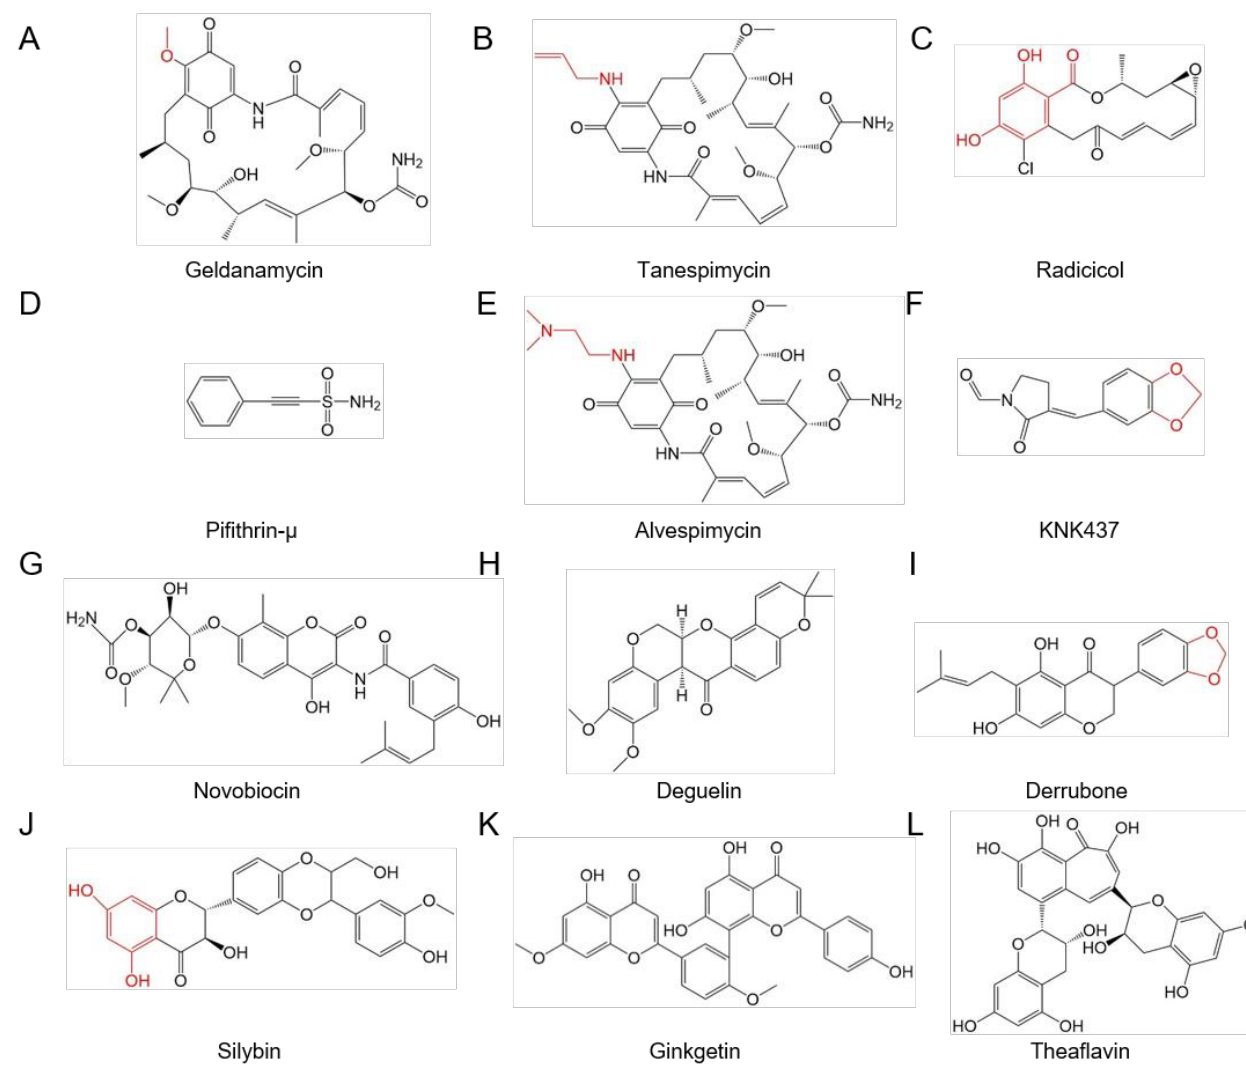
Figure 4. The molecule structure of HSP90 inhibitors. ( A ) Geldanamycin. ( B ) Tanespimycin. ( C ) Radicicol. ( D ) Pifithrin-µ. ( E ) Alvespimycin. ( F ) 3-(1,3-benzodioxol-5-ylmethylidene)-2-oxopyrrolidine-1-carbaldehyde. ( G ) Novobiocin. ( H ) Deguelin. ( I ) Derrubone. ( J ) Silybin. ( K ) Ginkgetin. ( L ) Theaflavin.